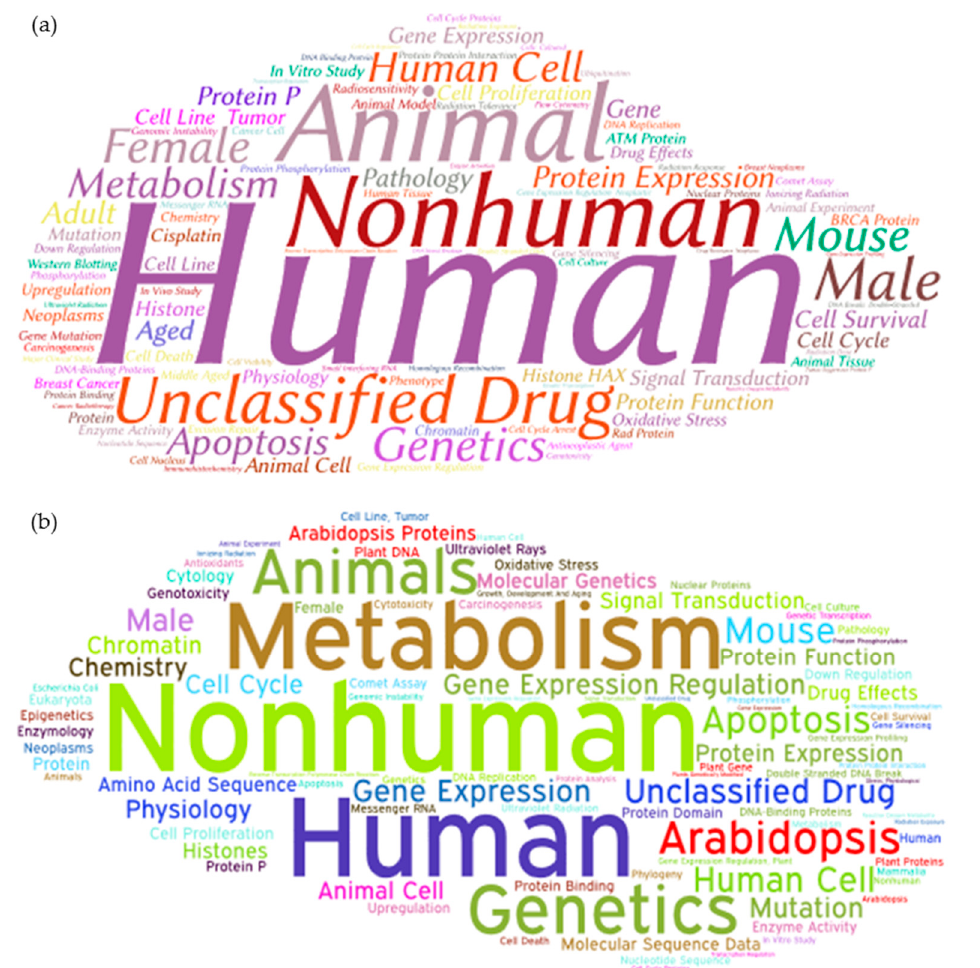
Figure 4. Cloud word based on the main keywords related to worldwide DDR ( a ) and DDR & Plant ( b ) research.